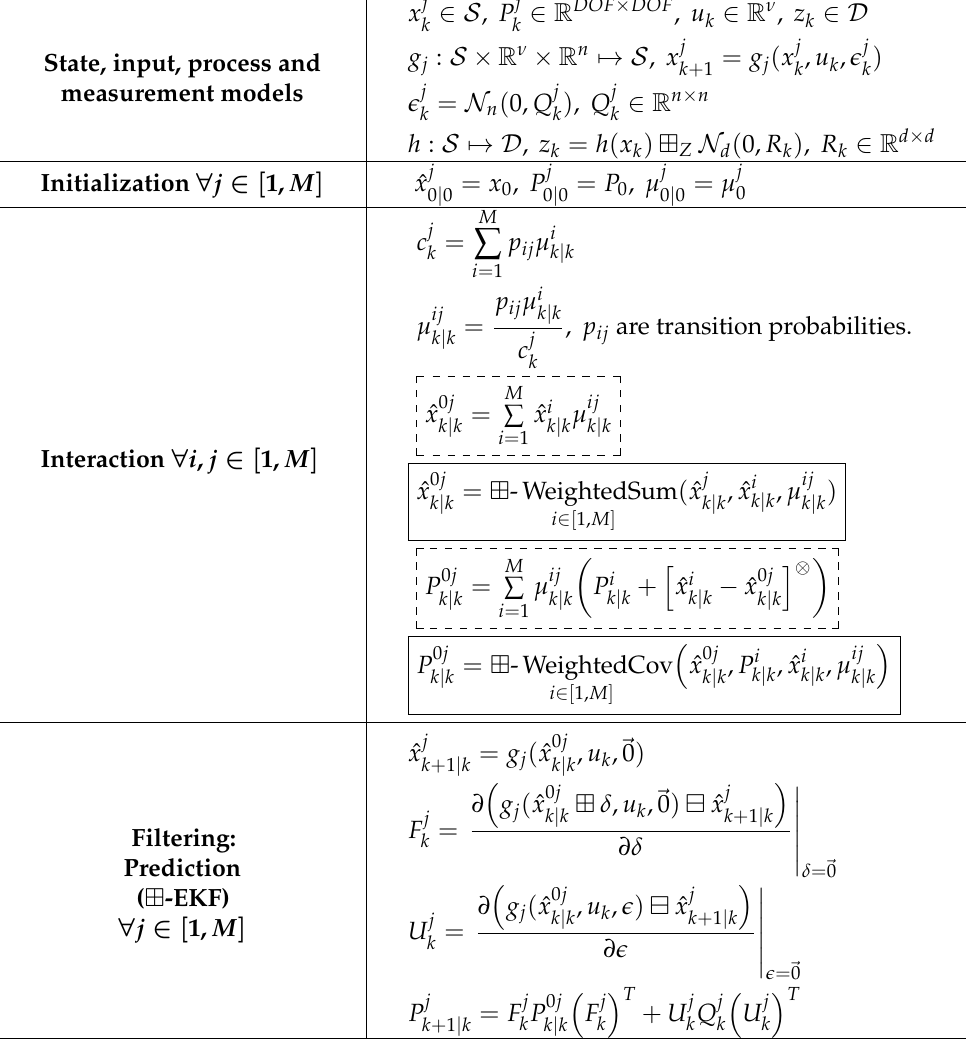
State, input, process and measurement